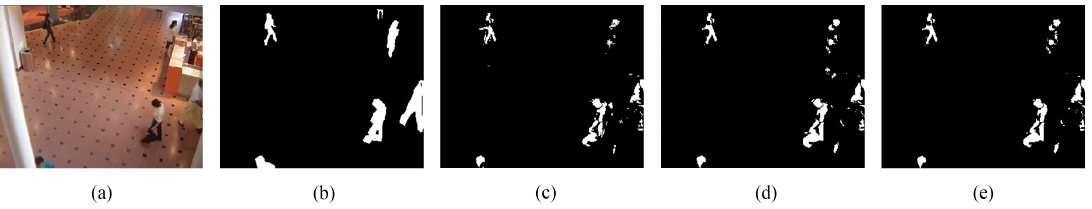
Figure 5. Our detection results of Frame 1740 of the shopping center sequence when N t equals 32, 64 and 128, respectively: ( a ) input frame; ( b ) ground-truth reference; ( c ) result when N t equals 32; ( d ) result when N t equals 64; ( e ) result when N t equals